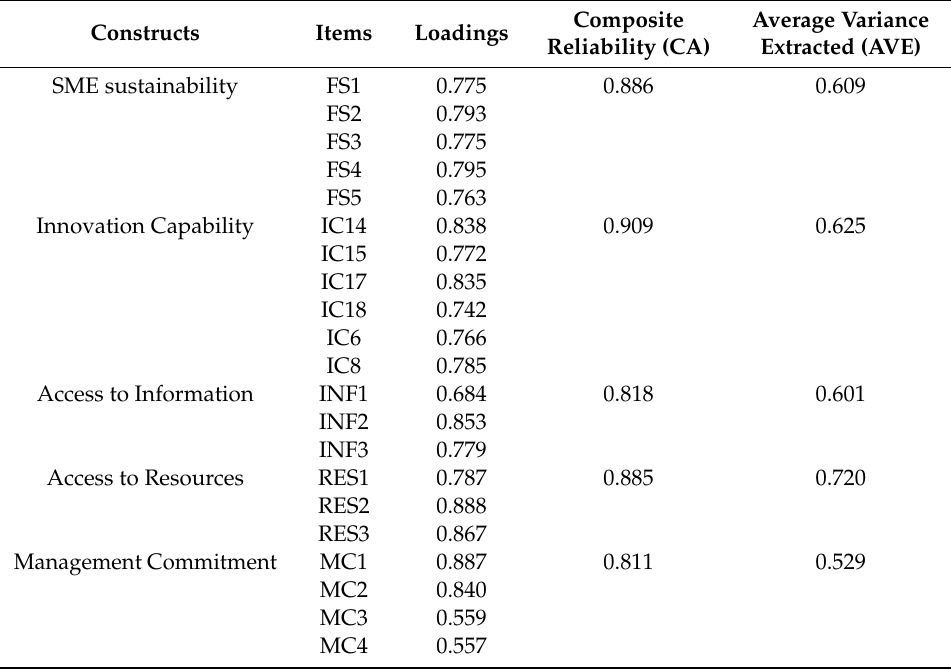
Table 1. Convergent